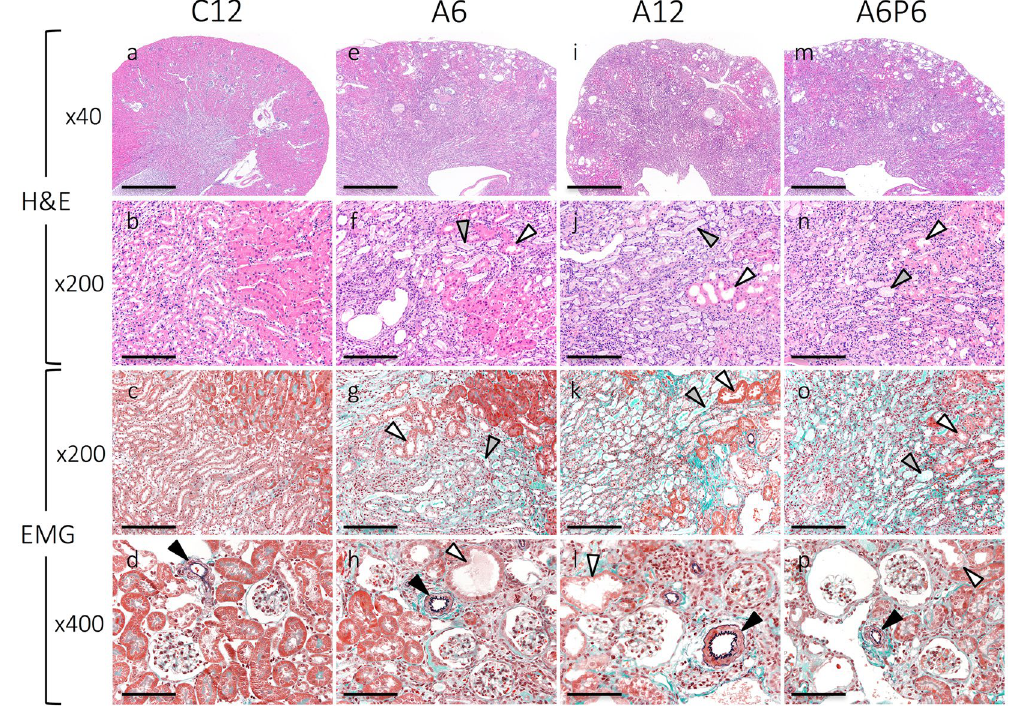
Figure 2. Representative histopathological findings in kidney tissues. Renal tissue was evaluated in each CKD-HP group using hematoxylin and eosin (H&E), elastica Masson-Goldner (EMG) staining. Mice from groups A6 ( e – h ), A12 ( i – l ) and A6P6 ( m – p ) group exhibited severe tubular impairment, with invasion of inflammatory cells, tubular luminal expansion ( f – h , j – l , n – p ; white arrowheads) and fibrotic changes in the stroma ( g , k , o ). Dropped tubular epithelium and casts was also evident in renal tubules ( f , g , j , k , n , o ; gray arrowhead). Kidney tissue of CKD mice showed atrophy, with an irregular surface ( e , i , m ). No morphological change in arterioles was identified in any group ( d , h , l , p ; black arrowhead). Scale bars = 500 μ m for ( a , e , i , m ), 100 μ m for ( b , c , f , g , j , k , n , o ), 50 μ m for ( d , h , l , p